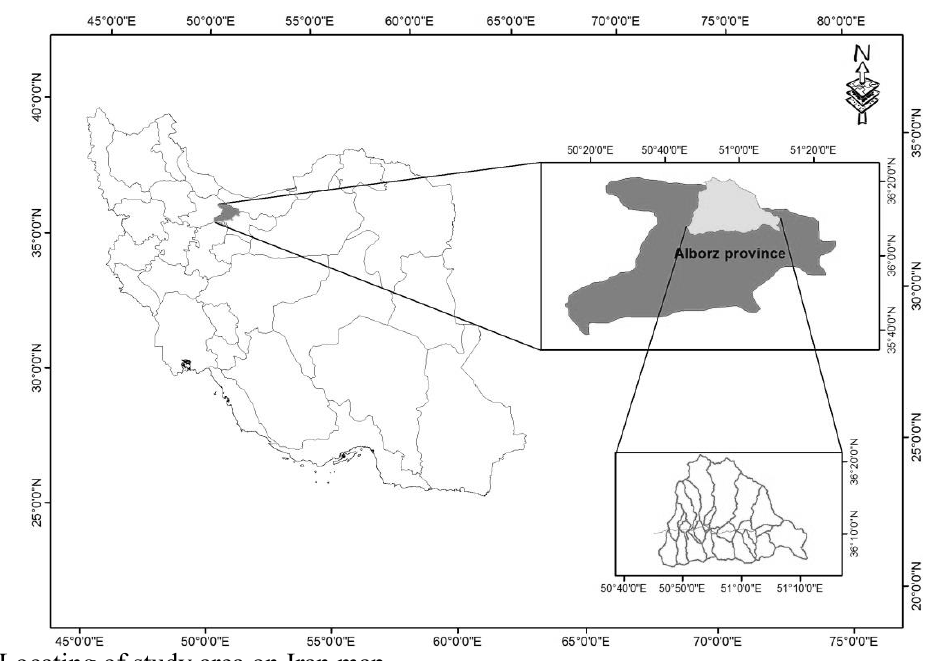
Figure 1 . Locating of study area on Iran